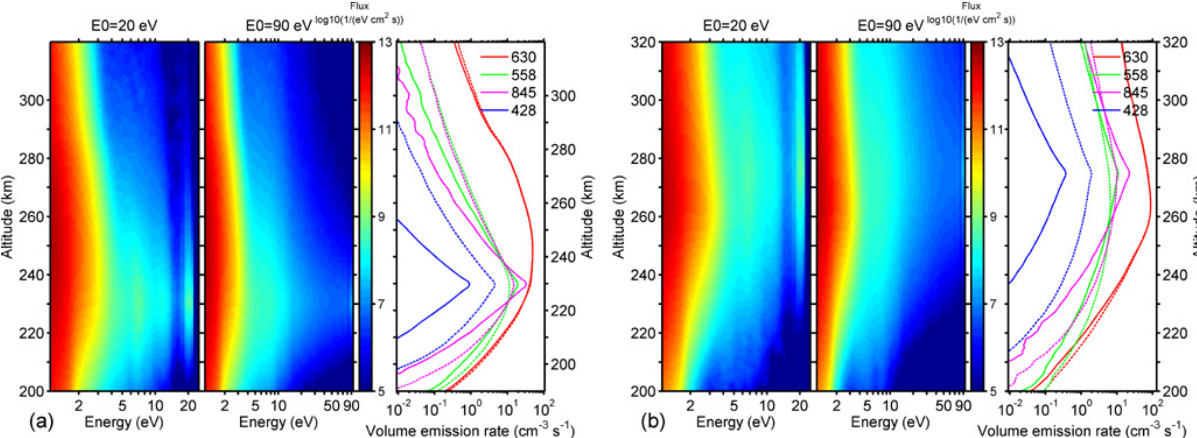
Fig. 5. (a) The electron differential flux and the volume emission rate for the heating pulse at 18:12UT. Left: The altitude energy variation of the electron flux for the mono-energetic accelerated electrons with an initial energy of 20eV. Centre: The same, but for an initial energy of 90eV. Right: Profiles of volume emission rates of the 630.0nm (red), 557.7nm (green), 844.6nm (magenta) and 427.8nm (blue) optical emissions. The solid lines correspond to an accelerated electron energy of 20eV, the dashed lines correspond to an energy of 90eV; (b) same as Fig. 7 for the heating pulse at 18:54UT.